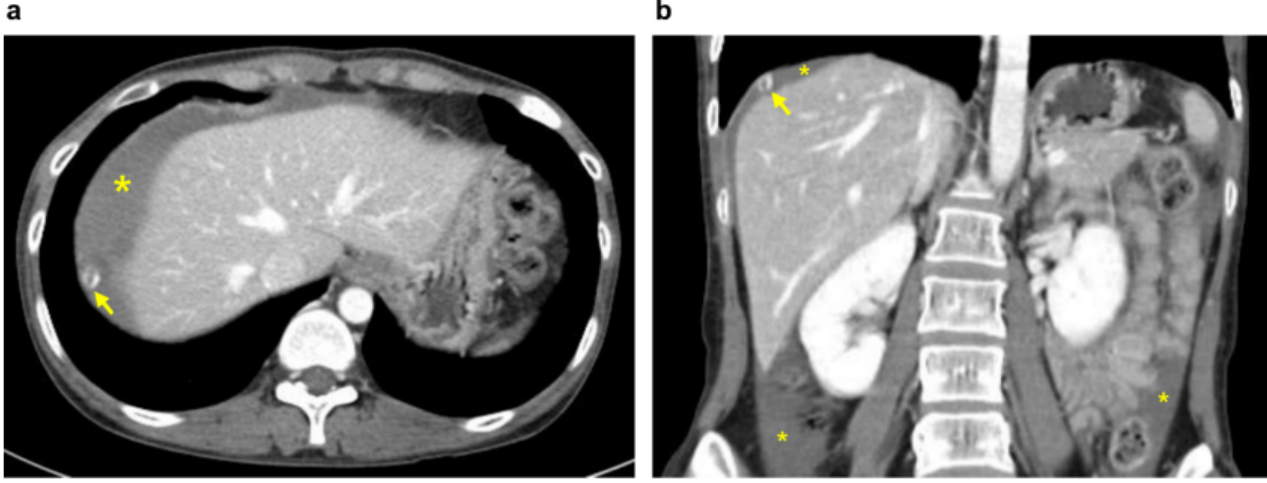
Figure 1. Abdominopelvic computed tomography images: A 2 cm target-like nodule with a thin, enhancing capsule (arrow); hemoperitoneum (*) in the axial ( a ) and coronal ( b ) planes.